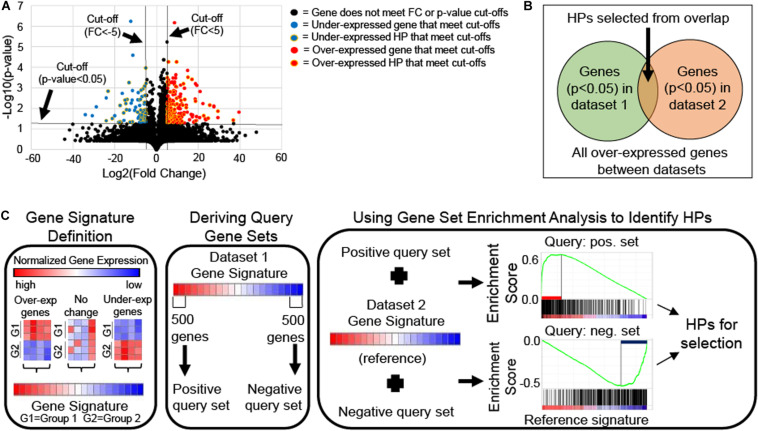
Schematics of differential gene expression approaches for hypothetical protein (HP) selection. (A) Volcano plot of mRNA expression data from Gene Expression Omnibus accession number GSE46687 identified HPs with statistical (two-tailed Welch’s T-test p-value < 0.05) and biological relevance [fold change (FC) > 5 for over-expressed or <–5 for under-expressed genes in experimental compared to control groups] to antibiotic resistance in Staphylococcus aureus that could be selected for the Hypothetical Protein Characterization Project. (B) Venn diagram illustrates conceptually how HPs are selected from singular enrichment analysis using the overlap of statistically significant (e.g., T-test p-value < 0.05) over-expressed genes between two mRNA expression datasets. The same concept applies to selecting under-expressed HPs also. (C) Schematic shows how HPs can be selected from gene signature comparison using Gene Set Enrichment Analysis (GSEA). Gene signatures are gene lists ranked by their differential expression based single-gene analysis (e.g., T-score or FC). A gene signature for each of two mRNA expression datasets are generated. One signature is chosen from which the 500 most over- and under-expressed genes are taken to derive positive and negative query gene sets, respectively. Each query gene set is compared individually to the second gene signature, which is used as reference for GSEA. GSEA calculates an enrichment plot with a maximum enrichment score. GSEA identifies leading-edge genes, which are genes that contribute most to reaching the maximum enrichment score. HPs among leading-edge genes are selected for the Hypothetical Protein Characterization Project.